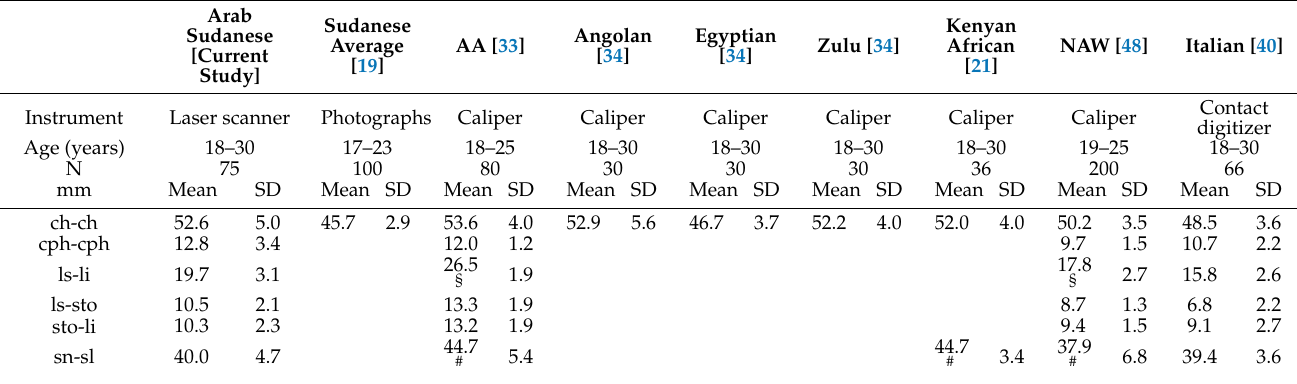
Table 4. Lip dimensions obtained in the current study and in the literature for young adult healthy African or African American women compared to data for Caucasoid women.